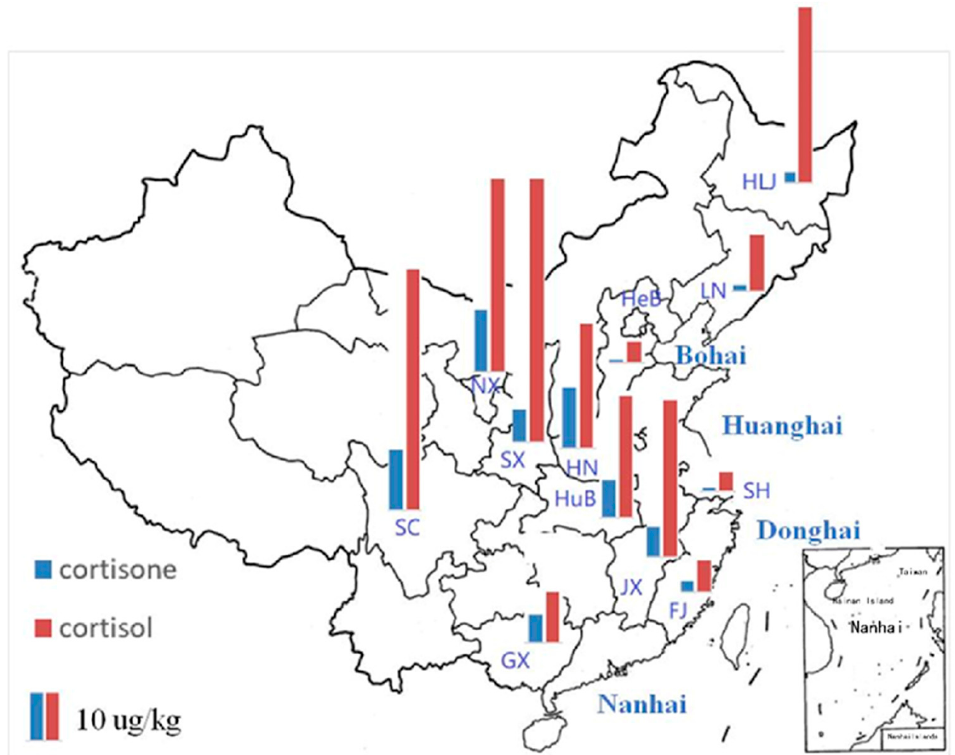
Figure 2. The map of concentration distribution of cortisone and cortisol in aquatic food samples from the fourth China TDS. Table 3. Analysis of aquatic foods consumption from 12 PLADs in the fourth China